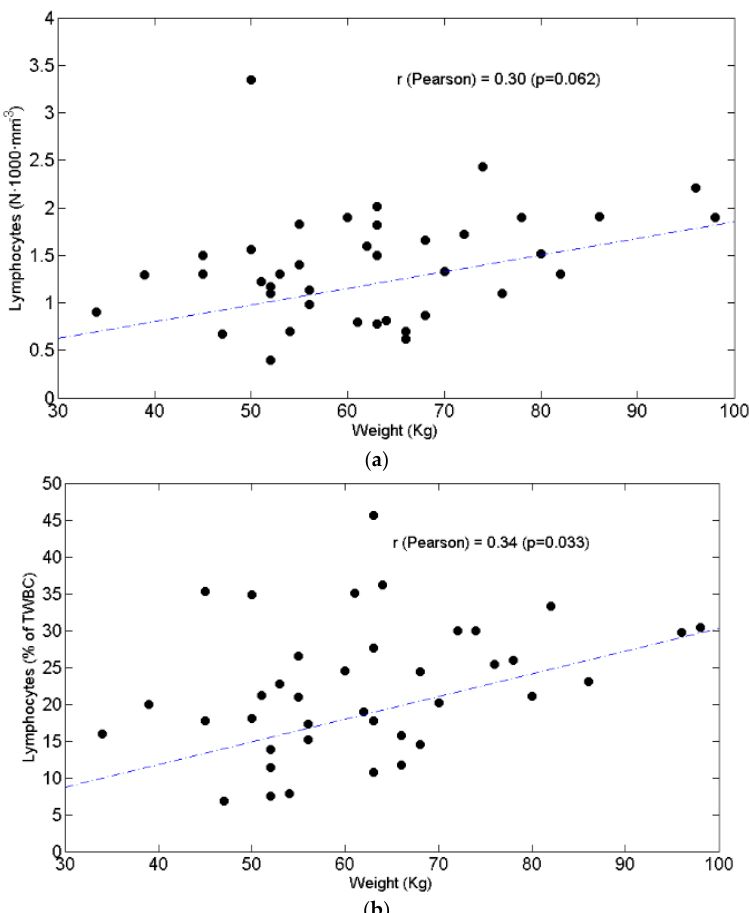
Figure 3. Scatter plots of the circulating lymphocytes (y axis) as a function of weight (x axis). Lymphocytes are expressed as absolute value ( a ) and as percentage of total white blood cells ( b ). The value of Pearson’s correlation coefficient and corresponding p value are also reported. TWBC: total white blood cells. Figure 4. Blood neutrophils/lymphocytes ratio is negatively correlated with body weight (Kg).